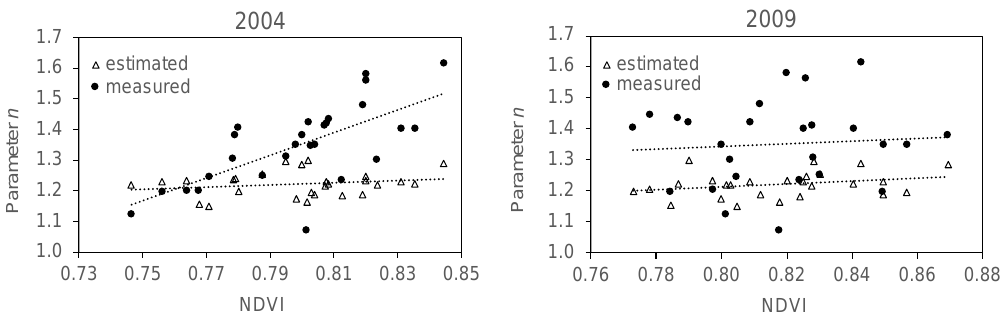
Figure 4. Measured (•) and estimated (Δ) values of n parameter vs NDVI values estimated by Landsat 8 images.